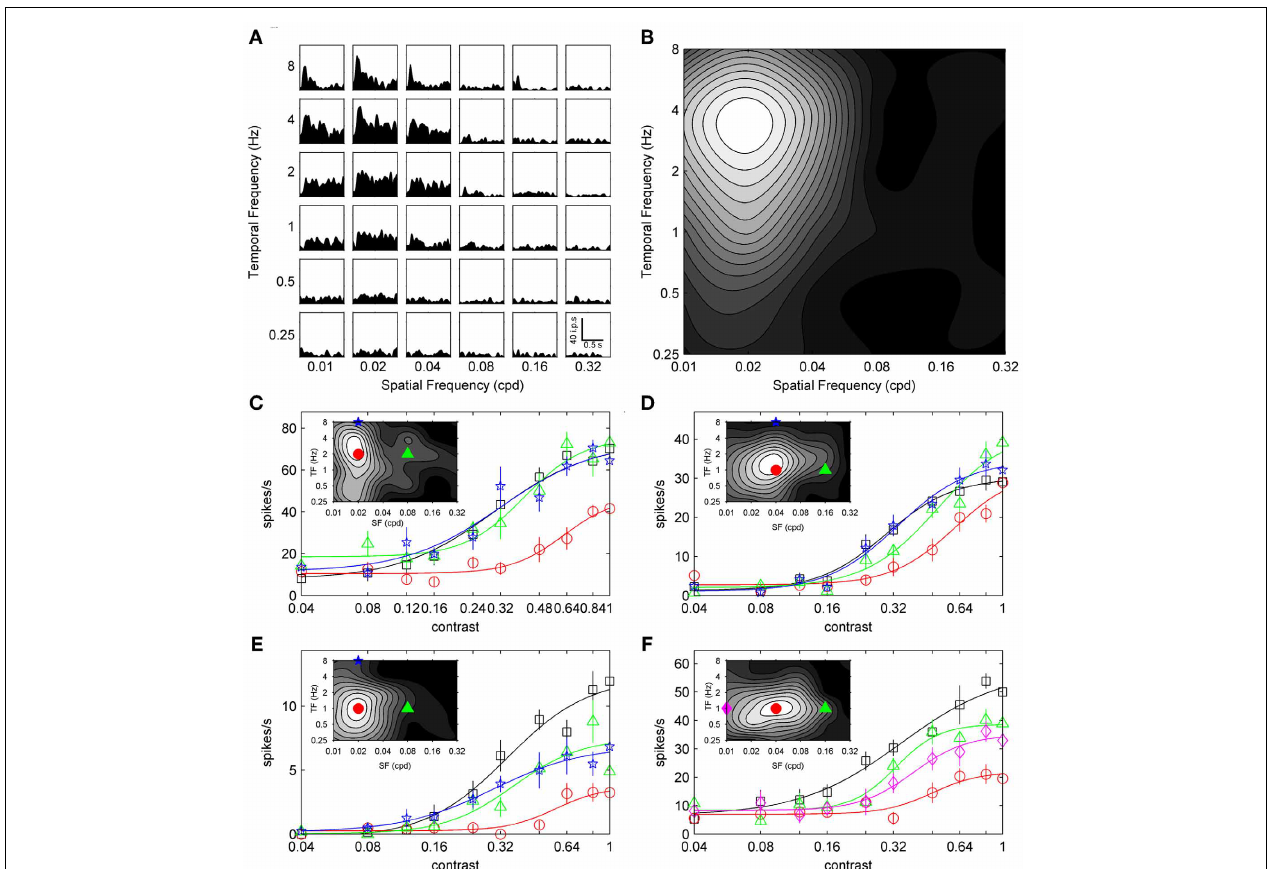
FIGURE 1 | Spatiotemporal specificity of top-up contrast adaptation. The spatiotemporal selectivity of a sample neuron is presented in (A) , with a grid of SDFs showing the neuron’s response to gratings with different combinations of SF (columns) and TF (rows). A scale bar depicting time vs. impulses per second (ips) is shown in the bottom right SDF (0.32cpd and 0.25Hz). Mean responses from SDFs are summarized as a grayscale contour plot in (B) (maximal firing shown in white), with SF on the abscissa and TF ordinate. (C–F) show contrast response functions from four sample neurons with contrast on the abscissa and mean response